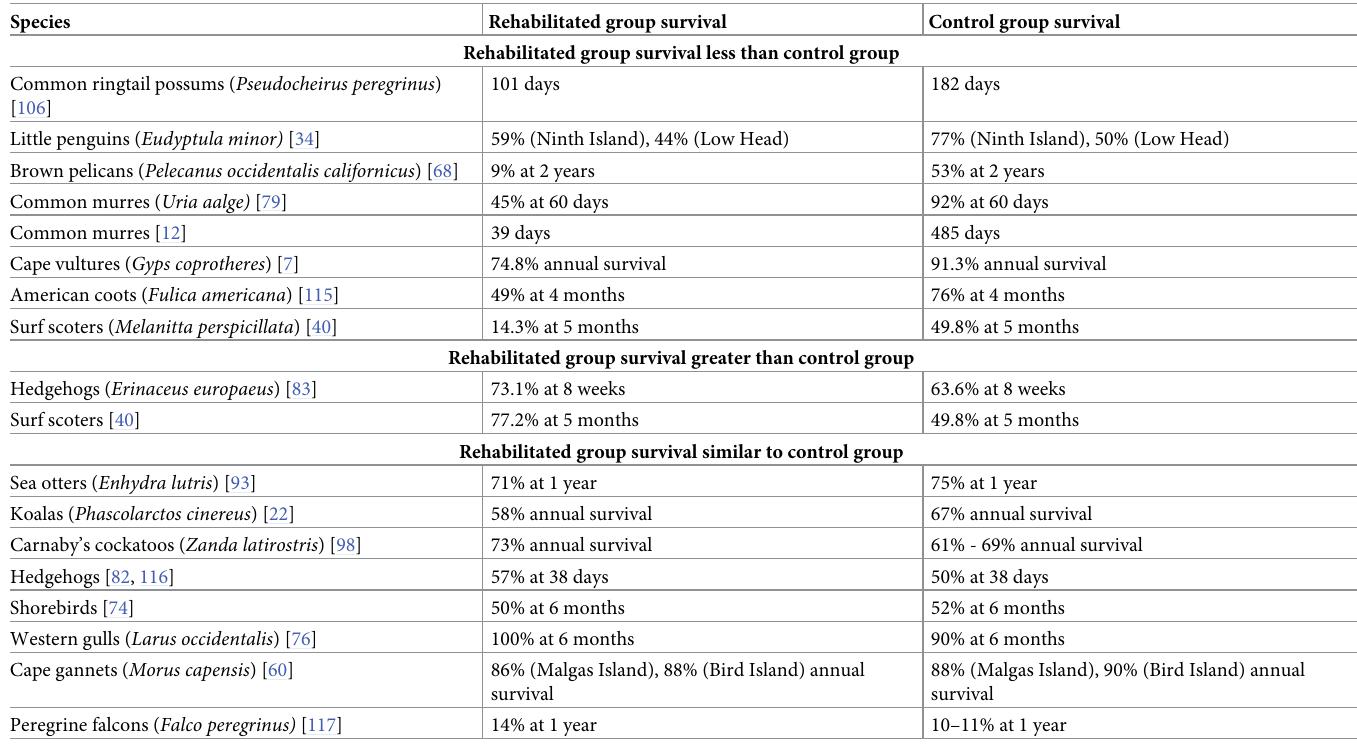
Table 5. Post-release survival of rehabilitated and control groups of various wildlife species grouped by survival pattern between the two groups. Species Rehabilitated group survival Control group survival Rehabilitated group survival less than control